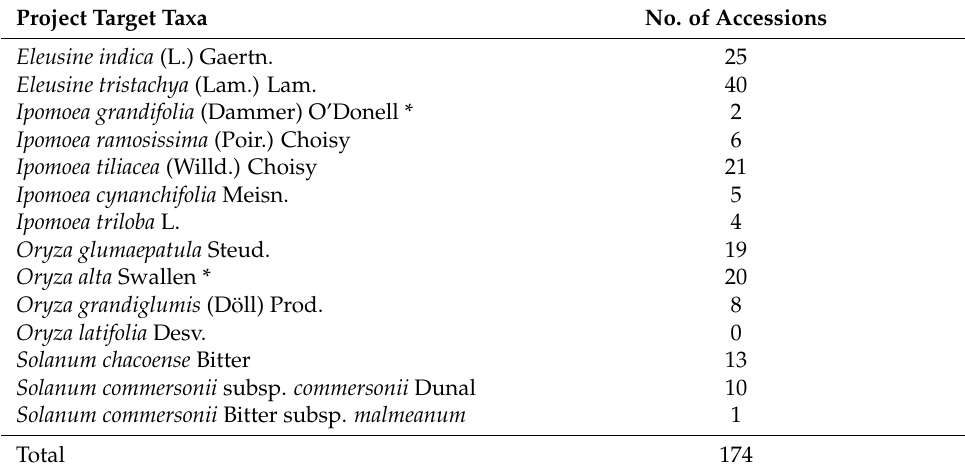
Table 4. Collected accessions of Oryza, Solanum, Eleusine, and Ipomoea wild species.